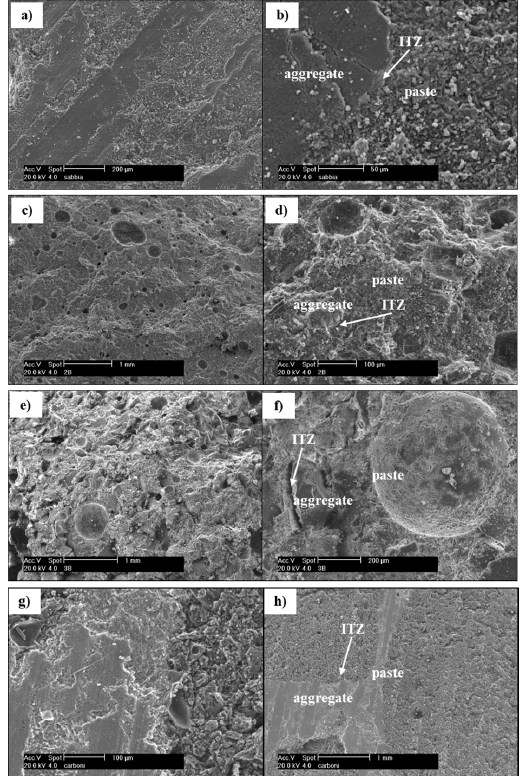
Figure 2. Scanning electron microscopy (SEM) images of mortars: ( a , b ) C-S; ( c , d ) C-A1; ( e , f ) C-A2; ( g , h ) C-A3.